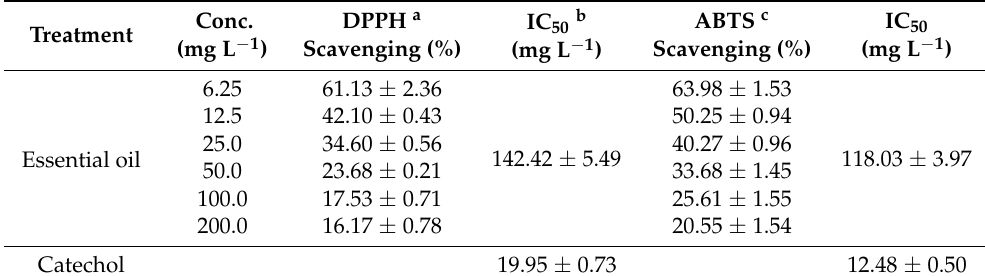
Table 4. Antioxidant activity of the essential oil and catechol as standard determined by scavenging of DPPH and ABTS